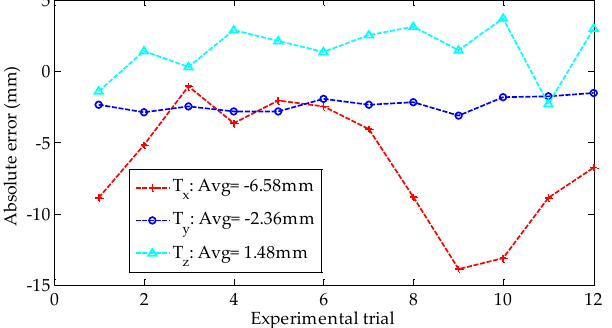
Figure 12. Absolute error of the translation vector.